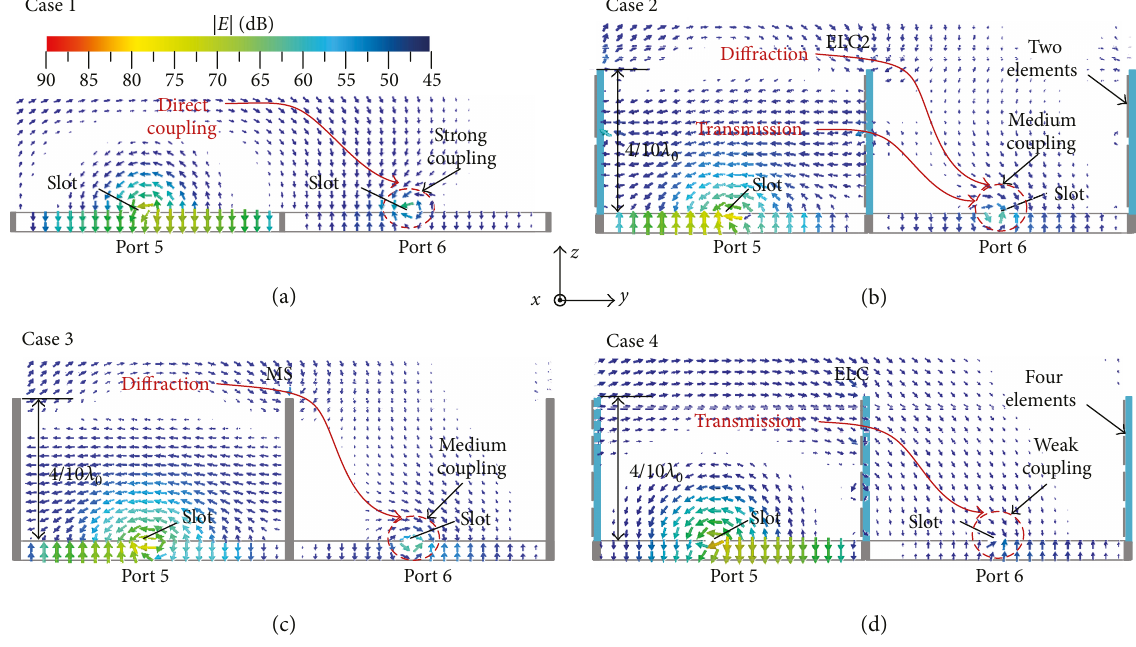
Figure 4: Cross-sectional E- fi eld mutual coupling between two adjacent SIWs at 10.0GHz in four cases: (a) case 1: without WAIM, (b) case 2: with the ELC2 metasurface slab, (c) case 3: with a metal slab (MS), and (d) case 4: with the ELC metasurface